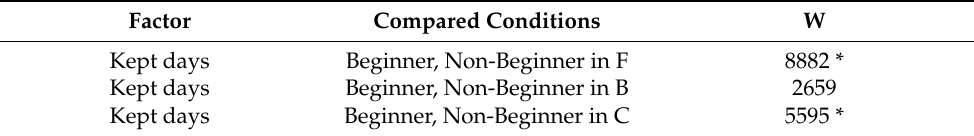
Table 8. Post-hoc Mann–Whitney tests results for the varaible “Kept Days” run on the sub-samples of beginners and non-beginners. Factor Compared Conditions W Kept days Beginner, Non-Beginner in F 8882 * Kept days Beginner, Non-Beginner in B 2659 Kept days Beginner, Non-Beginner in C 5595 * * p < 0.016 (Bonferroni